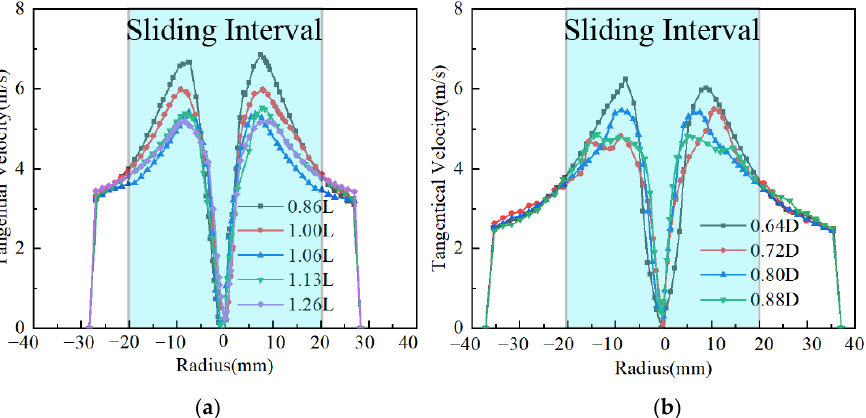
Figure 12. Influence of insertion depth of the internal vortex finder on tangential velocity. ( a ) z = 150 mm ( b ) z = 200 mm.